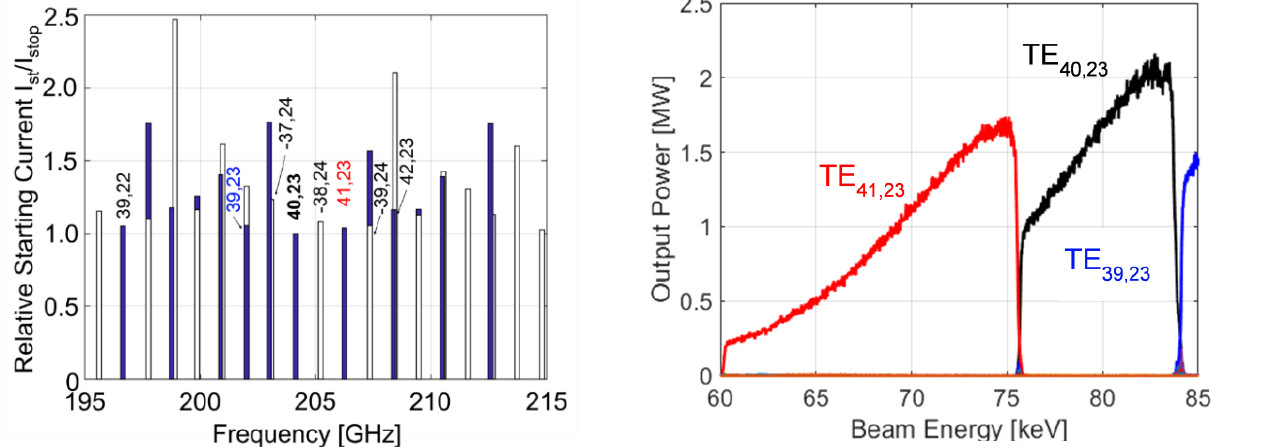
Fig. 1. Relative starting current of competing modes at 8.15 T and I beam = 70 A (filled bars: co-rotating; empty bars: counter rotating modes) [12].